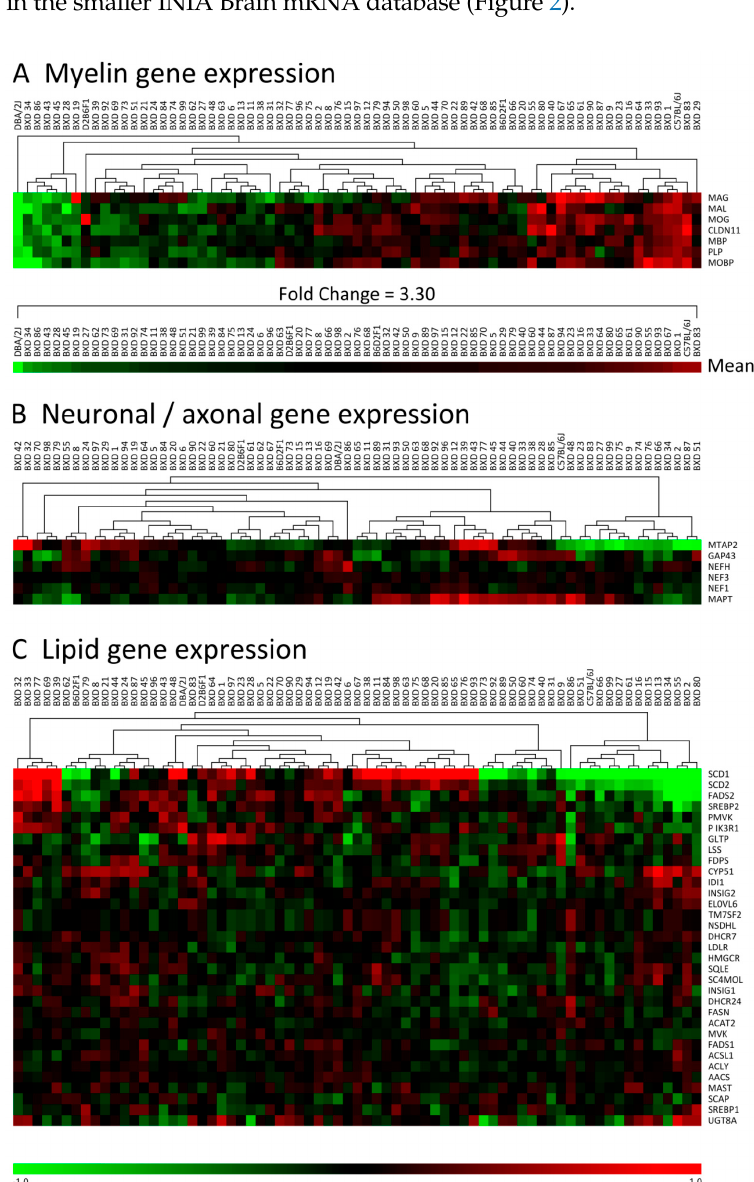
Figure 1. Clustering of gene expression data shows pronounced differences in myelin gene expression between C57BL / 6J (C57), DBA / 2J (DBA), and their BXD progeny. BXD microarray data were obtained from the GeneNetwork ‘Hippocampus Consortium PDNN’ dataset. Transcripts were selected and their gene expression patterns clustered using Euclidean distance and average linkage clustering. ( A ) The clustering pattern indicates a clear group regulation of all myelin transcripts investigated, with the parental strains C57 and DBA opposite at the most extreme ends. ( B , C ) Clustering of transcript data related to axonal / dendritic markers and lipid metabolism, respectively, did not reveal similar patterns of co-regulation. The number of strains is 71. The scale bar is depicting Log2 gene expression values. The intensity threshold was set to 0 for all depicted functional groups (i.e., myelin, axonal / dendritic and lipid